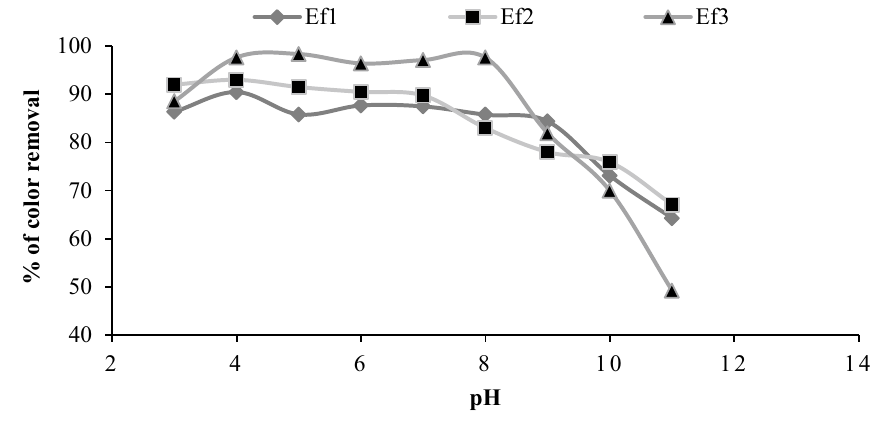
Fig. 4 Effect of pH on the color removal efficiency of the coagu- lant from textile dyeing effluents (coagulant dose 300 mg/L, agitation speed 60 rpm and temperature 30 °C for PAC